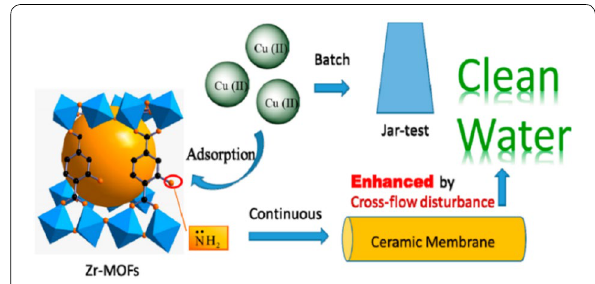
Fig. 12 Cu 2 + adsorption process onto Zr-MOFs via CM novel cross-flow disturbance. (Reprinted from